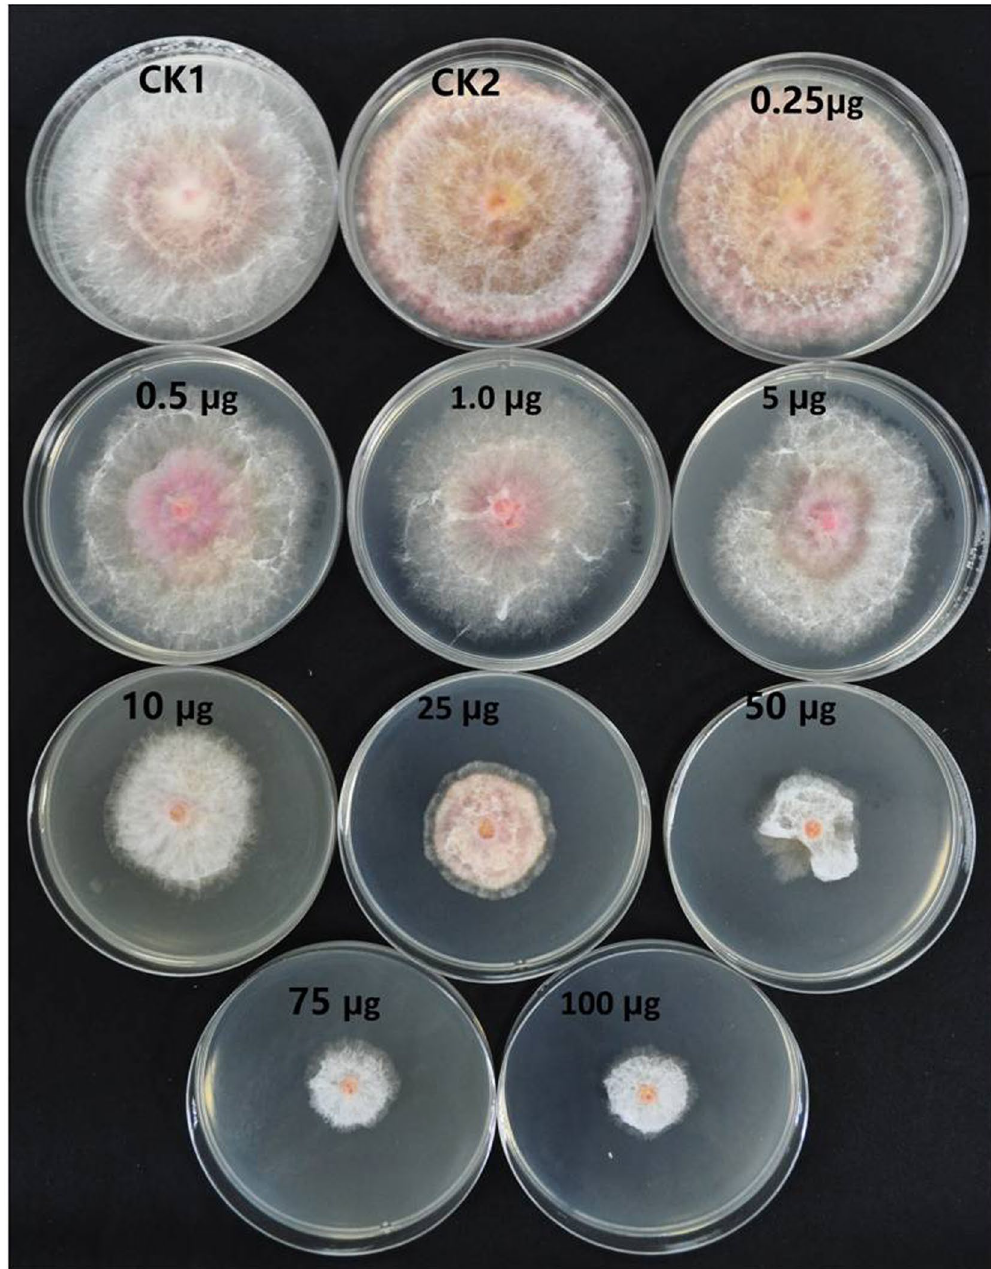
Figure 6. Effect of bioactive fungal metabolite derived from T. harzianum strain CCTCC-RW0024 ( μ l/100 ml of PDA) on growth of